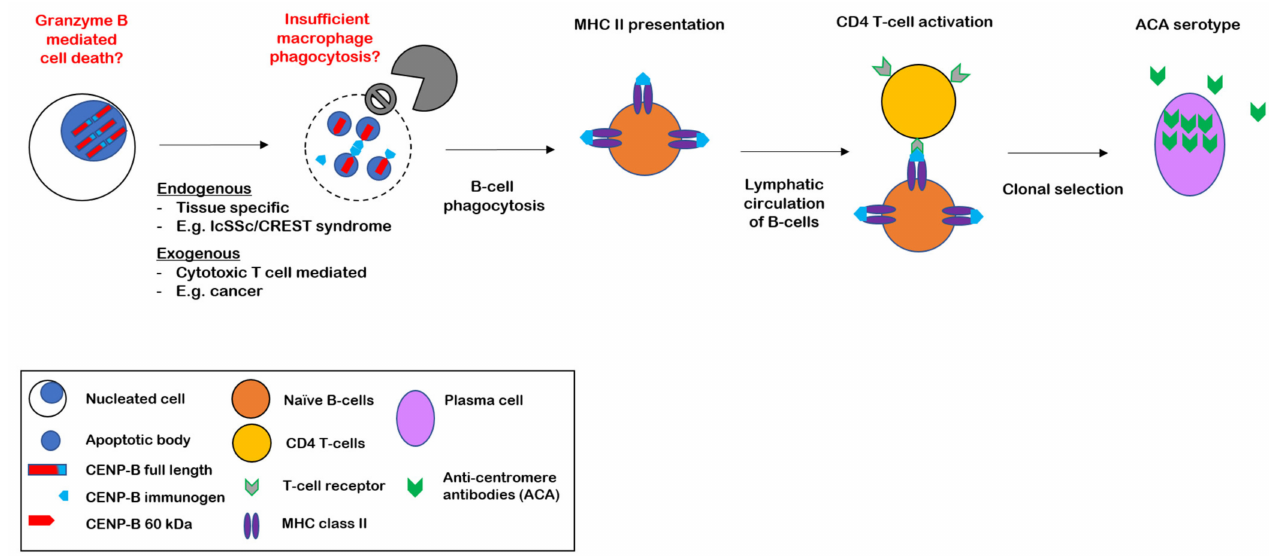
Figure 4. Proposed model for ACA serotype development. The characteristics of ACAs are highly suggestive of a polyclonal, B-cell-mediated response involving MHC class II presentation (see the main text for details). The mechanism and physiologic conditions of autoantigen formation are still unknown. Granzyme B is a candidate for involvement, supported by in vitro CENP-B studies and correlations with cellular involvement in autoimmunity (endogenous) and cancer (exogenous). Insufficient macrophage clearage of theoretical cell-death-associated, CENP-B cleavage products can be reasonably predicted to increase the likelihood of B cell phagocytosis, T cell activation, and, ultimately, ACA serotype formation in the susceptible immunogenetic